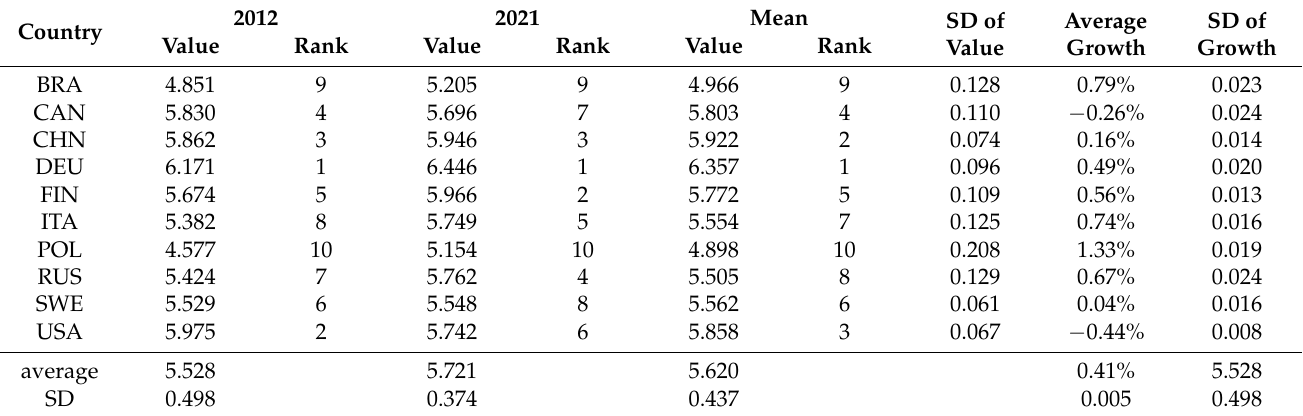
Table 4. The results of the international competitiveness of wood-based paper